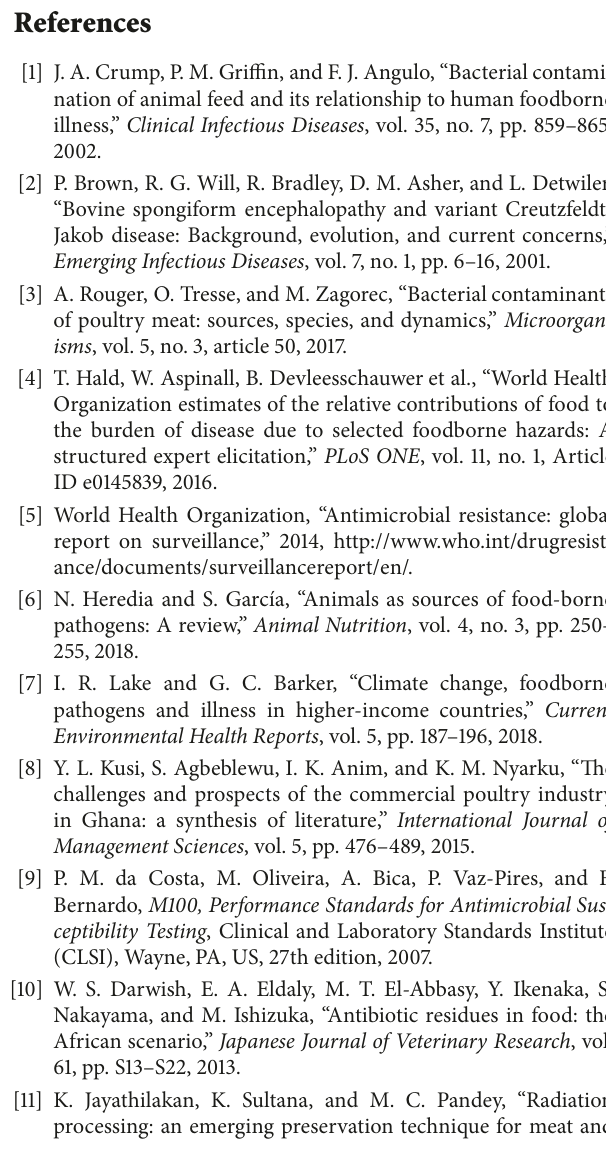
Table 3: Antibiotic resistance patterns of 11 bacterial isolates from feed samples. Antimicrobials No. of Isolates Tested Resistant N(%) Intermediate N(%) Sensitive N(%) PEN., AMP., FLX. 11(100%) 11(100%) 0(0) 0(0) ERY. 11(100%) 10(90.9%) 0(0) 1(9.09%) TET. 11(100%) 8(72.7%) 0(0) 3(27.3%) CRX. 11(100%) 7(66.6%) 0(0) 4(36.4%), CTX. 11(100%) 5(45.4%) 0(0) 6(54.5%) CHL., CTR 11(100%) 4(36.4%) 0(0) 7(66.6%) GEN. 11(100%) 3(27.3%) 0(0) 8(72.7%) COT. 11(100%) 2(18.2%) 0(0)